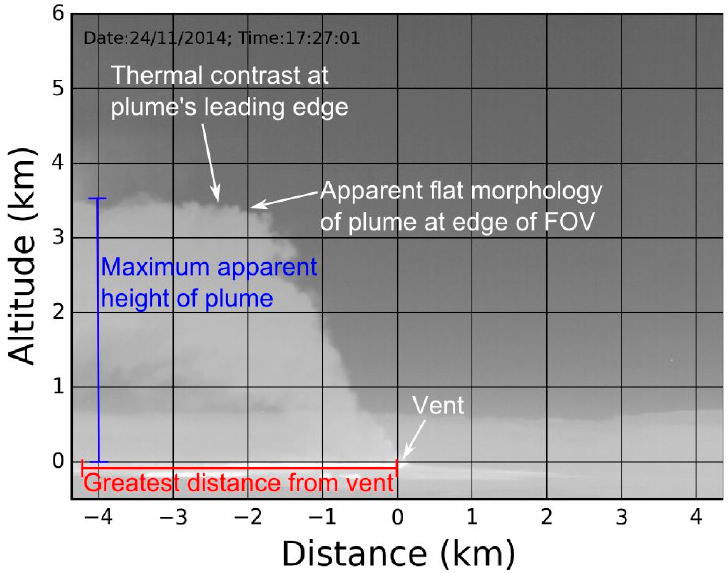
Figure 4. Apparent cloud top height measured from NicAIR II 10 μ m images.